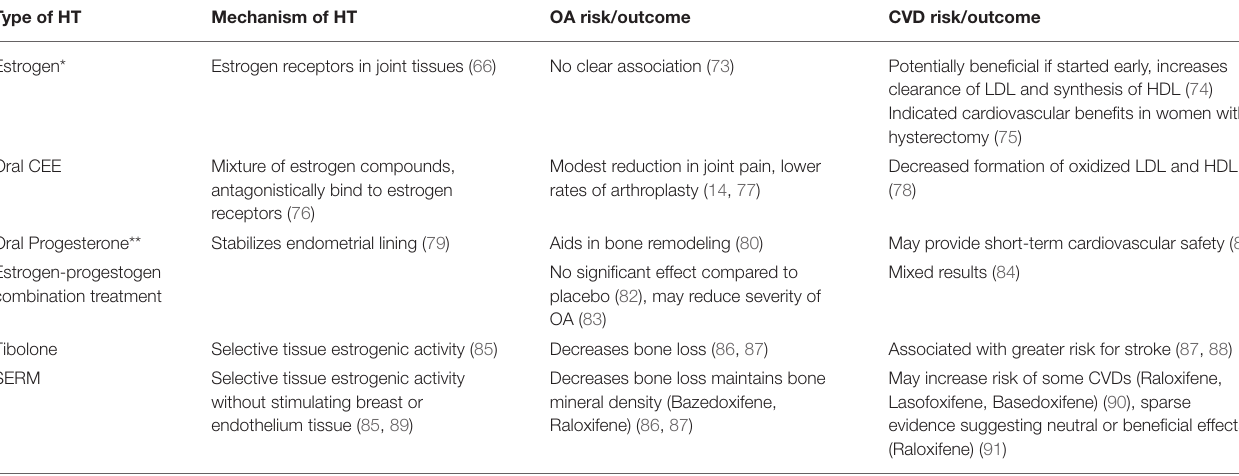
TABLE 1 | Overview of the influence of HT on OA/CVD